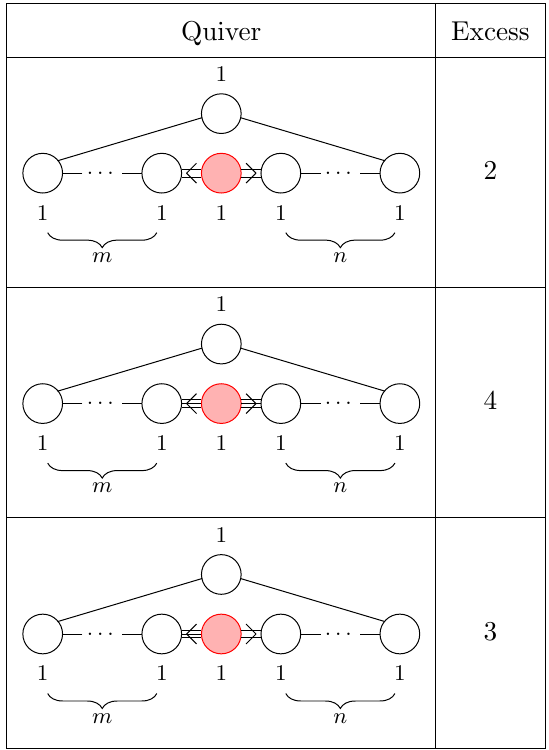
Table 36 . Classi(cid:12)cation of very exotic A -type minimally unbalanced ring quivers with two non- simply laced